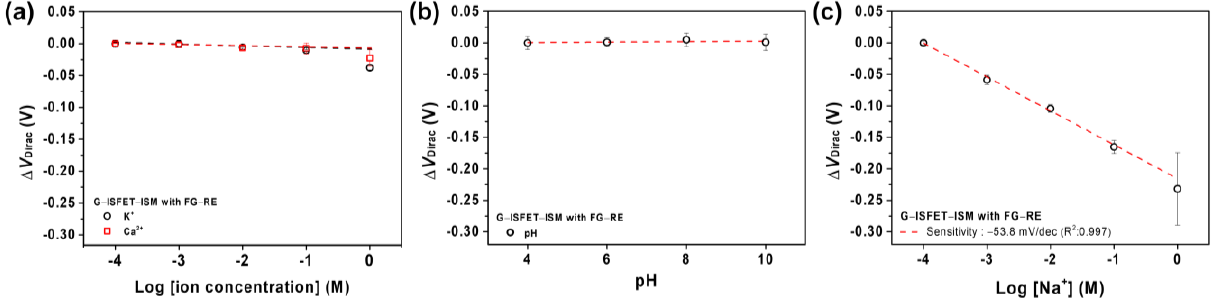
Figure 5. ( a ) Sensitivity of G–ISFET–ISM with FG–RE to K + and Ca 2+ ions in Tris–HCl buffer, in which 100 mM NaCl was dissolved. Linear fits were used to extract sensitivity; ( b ) sensitivity to pH in Carmody buffer; and ( c ) sensitivity to Na + ions in Tris–HCl buffer, in which 100 mM KCl was dissolved.